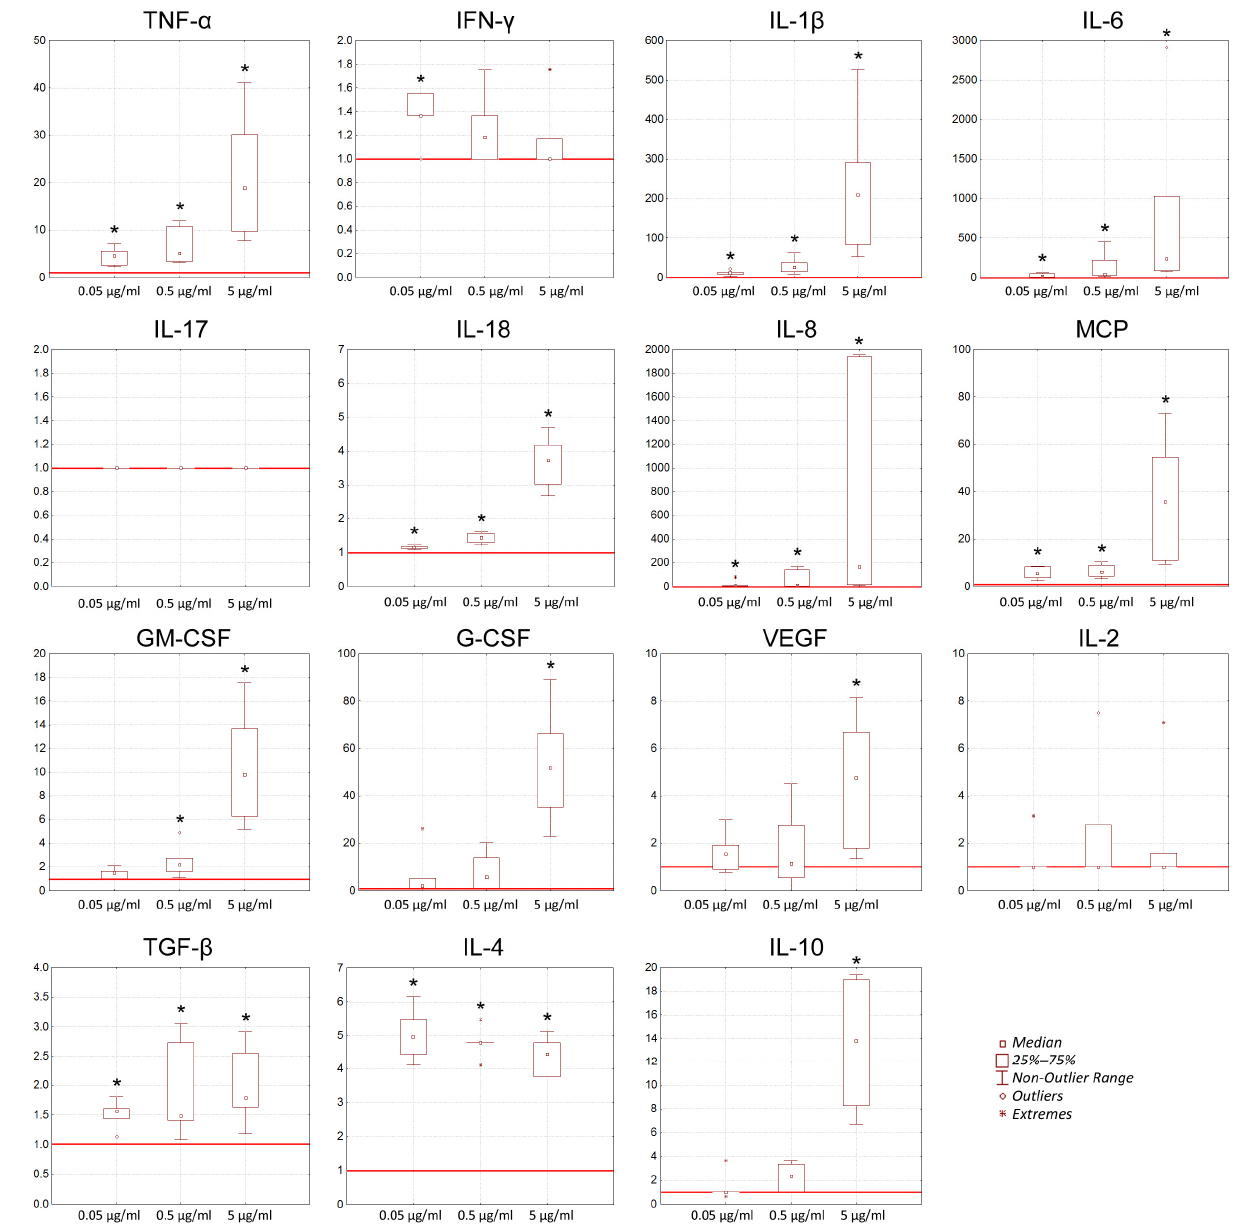
Figure 3. Induction of cytokine production by GcMAF-RF-activated whole blood cells of healthy donors. The Y axis represents the impact index: the ratio between cytokine production after exposure to GcMAF-RF at a certain concentration and constitutive cytokine production taken as unity (red line). * significant differences in cytokine production after exposure to GcMAF-RF relative to constitutive cytokine production ( n = 6), p < 0.05 (Mann–Whitney U test).